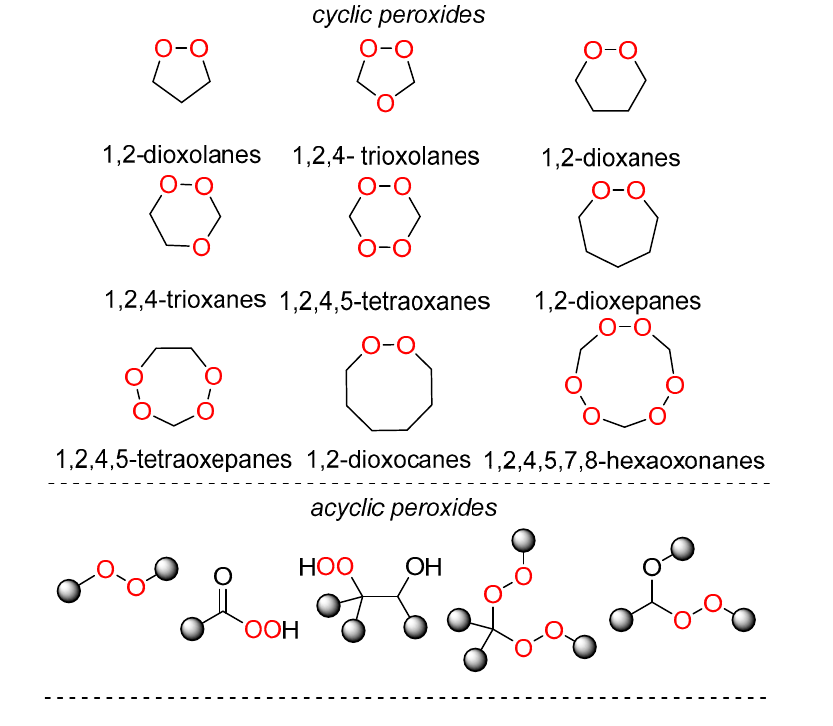
Figure 2. Reviewed cyclic and acyclic peroxides.